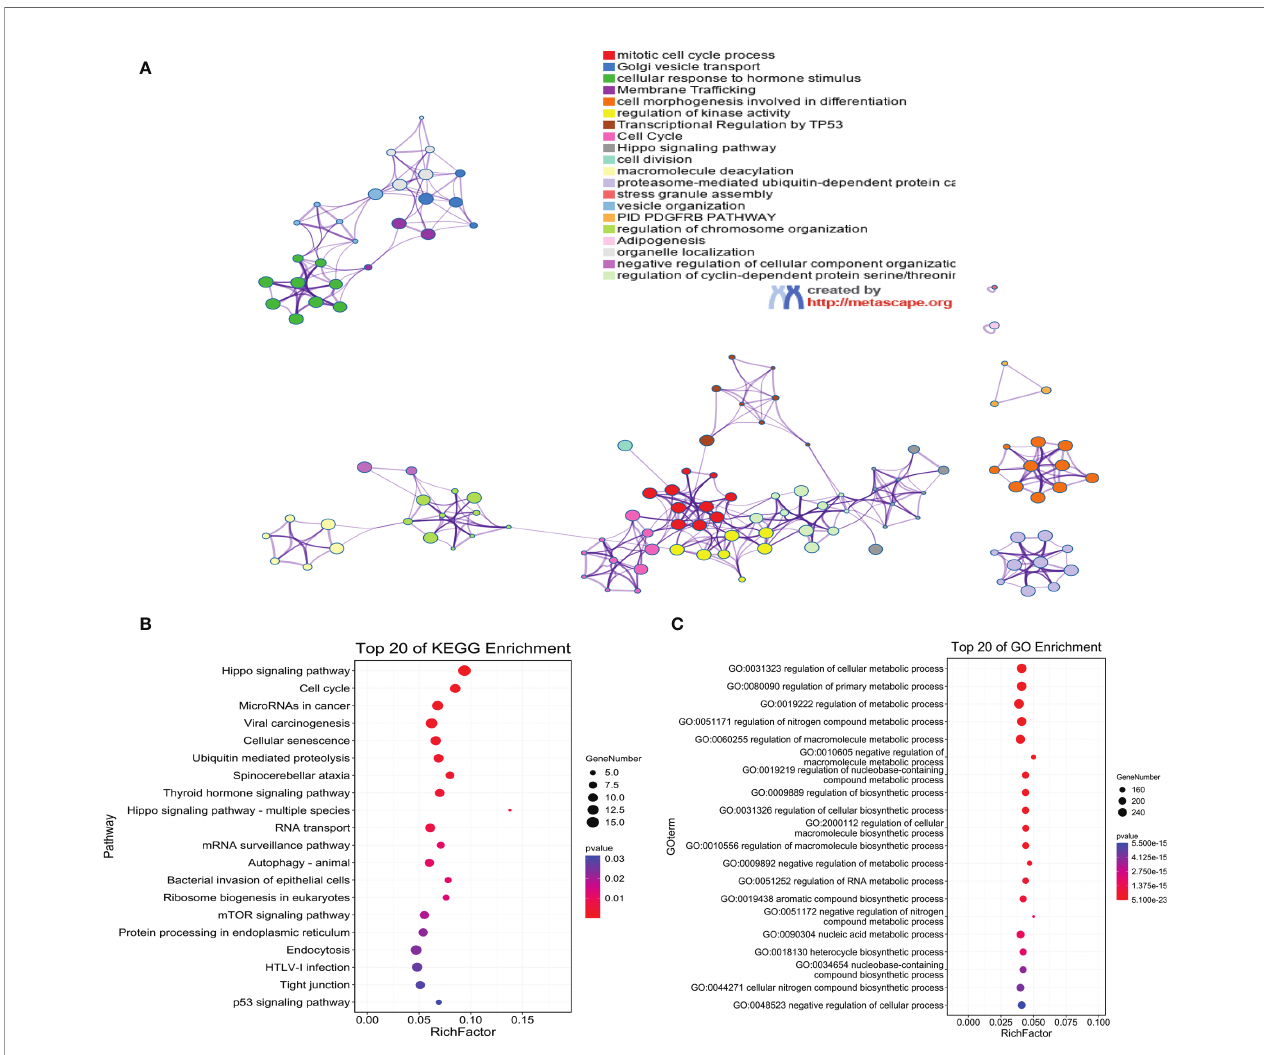
FIGURE 7 | Functional annotation of target genes. (A) PPI network diagram of target genes; (B) KEGG enrichment analysis; (C) GO enrichment